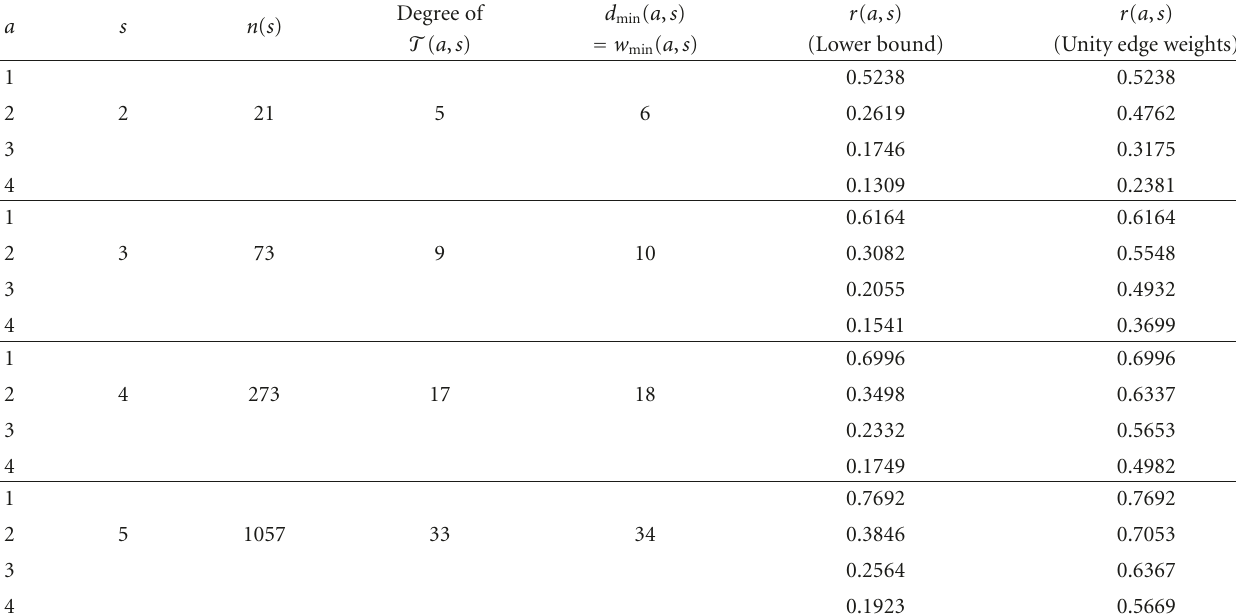
Table 1: Properties of C ( a , s ) .